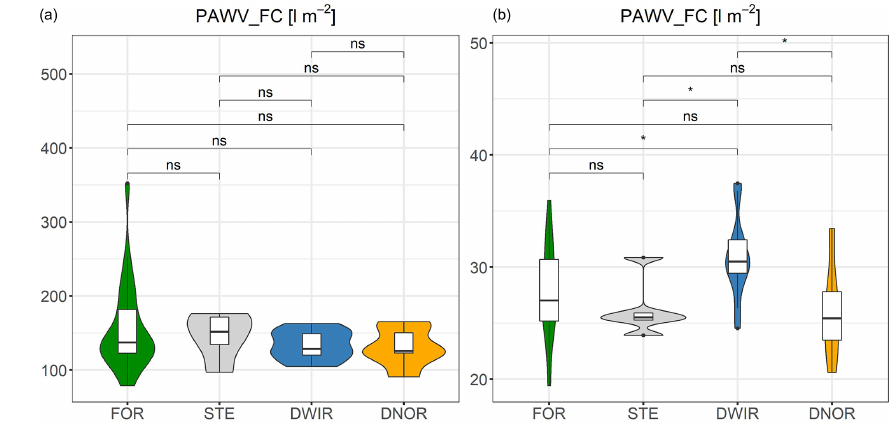
Figure 8. Calculated plant-available water volume at field capacity (PAWV FC ) per square metre stored in entire soil profiles (a) and stored in only the uppermost 10cm of soil profiles (b) under the following four vegetation categories: near-natural forest (FOR; green), steppe close to forest (STE; grey), disturbed forest with regrowth of trees (DWIR; blue), and disturbed forest showing no regrowth of trees (DNOR; orange). n = 49, and P values were calculated for differences between the arithmetic means (ns – p> 0 . 05; ∗ – p ≤ 0 . 05; ∗∗ – p ≤ 0 . 01; ∗∗∗ – p ≤ 0 . 001; ∗∗∗∗ – p ≤ 0 . 0001). Horizontal bars are medians, boxes are first and third quartiles, points are outliers, and violins are data